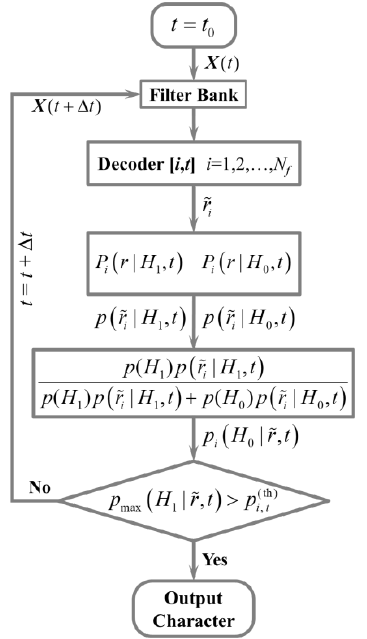
Figure 5. The flowchart of online recognition with dynamic stopping (DS) strategy.